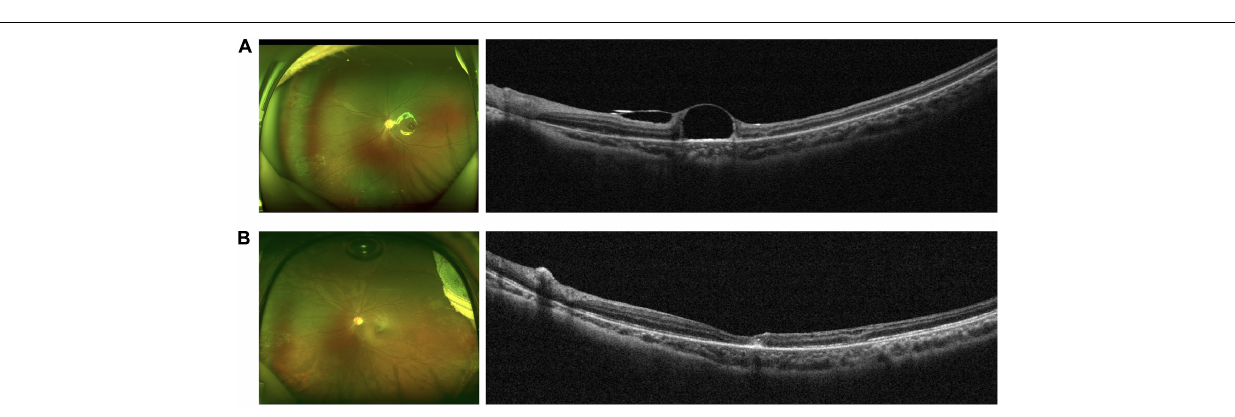
FIGURE 2 | Clinical characteristics of a representative patient (case 5). (A) Pre-operative fundus photograph (left) and OCT image (right) showing a subfoveal PFCL droplet. (B) Fundus photograph (left) and OCT image (right) confirming removal of the subfoveal PFCL with relatively good macular